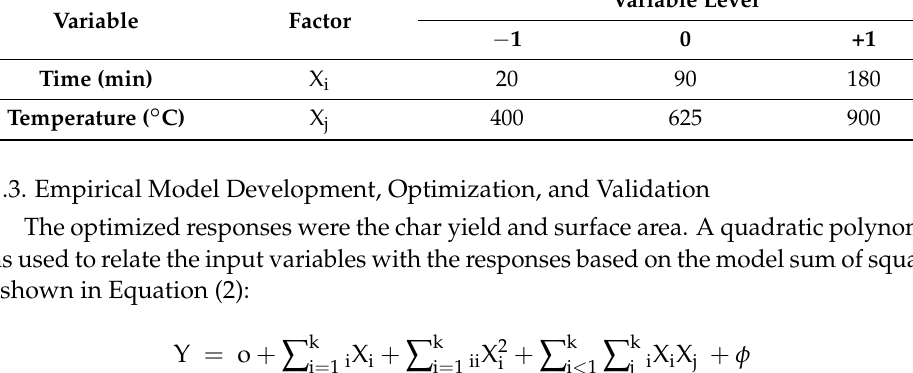
Table 1. Independent variables and their coded levels. Variable Factor